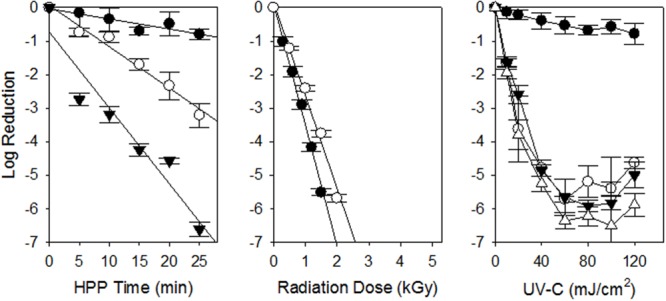
Inactivation of uropathogenic Escherichia coli on chicken meat and chicken purge by non-thermal processing technologies. HPP 300 (•), 400 (∘) and 500 (▼) MPa are shown as well as gamma radiation at 4 (•) and -20 (∘) °C. For UV-C inactivation of UPEC on chicken breast meat (•), and chicken exudates on SS (∘), HDPE (▼) and HDPP (Δ) are shown. Each experiment was conducted independently three times (n = 3). The standard error of the mean is shown as error bars. The linear regressions are shown as solid lines.